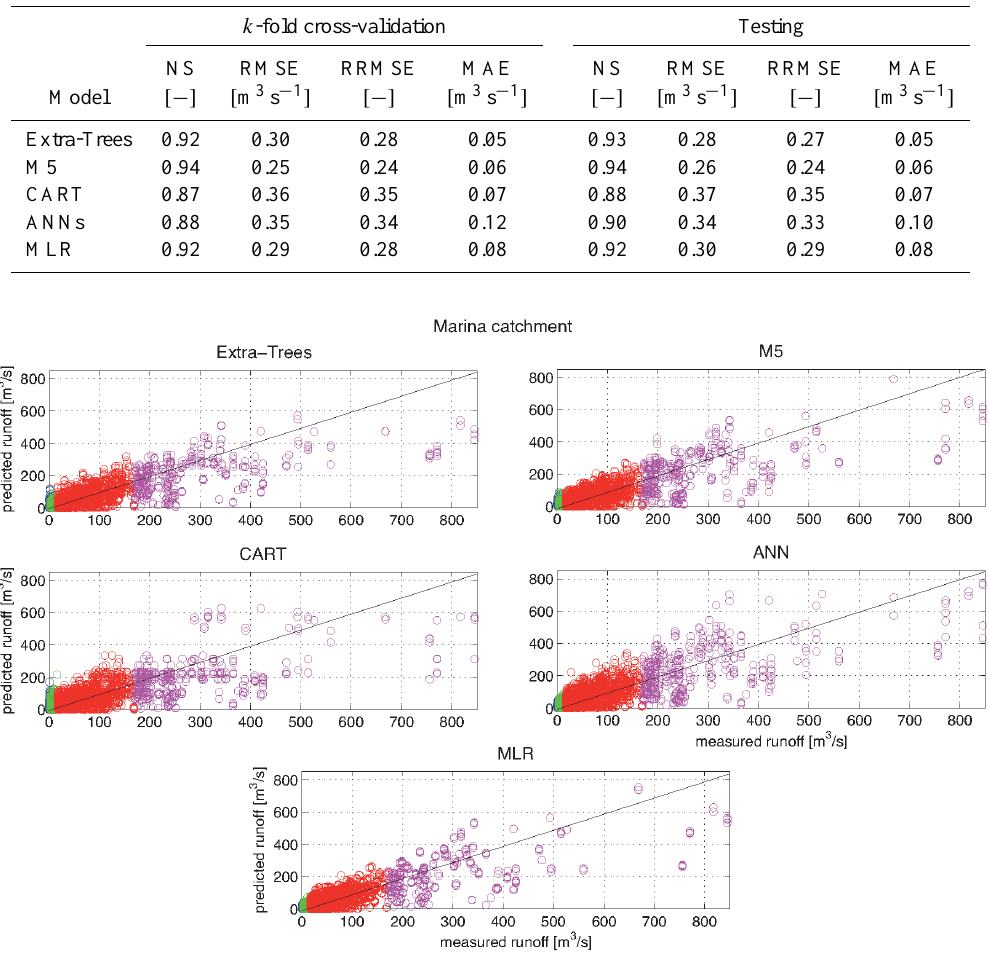
Fig. 5. Scatter plots of predicted (y-axis) and measured (x-axis) streamflow [m 3 s − 1 ] in Marina catchment for the different models on the testing subsets. Different colours are used to represent the flow regimes: blue, green, red and purple correspond to base, low, intermediate and high flow,